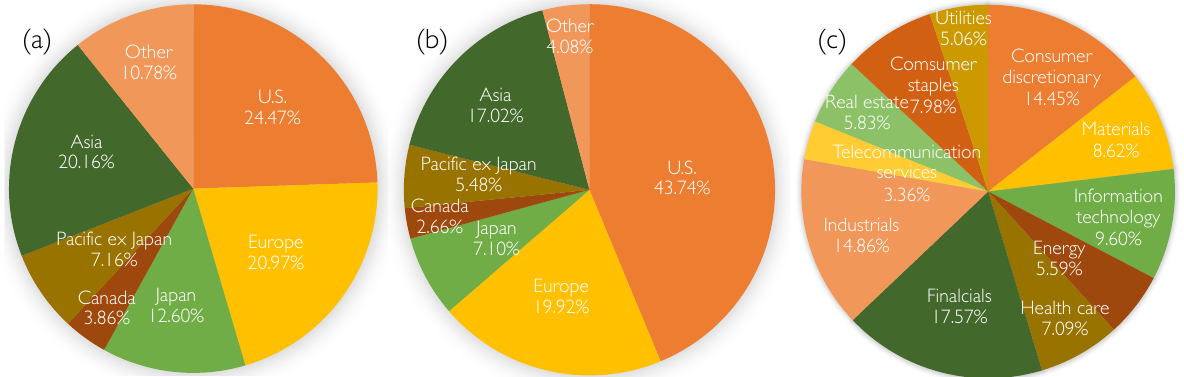
Figure 3. Distribution of All country world index (ACWI) by ( a ) financial companies’ locations, ( b ) market cap, and ( c ) sectors as of August 2017.